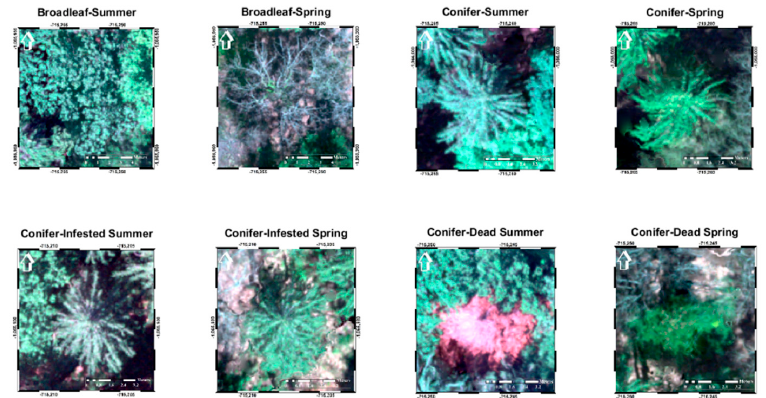
Figure 4. Examples of zoomed tree canopies on different tree species and health status from both seasonal periods in RGB spectral bands.